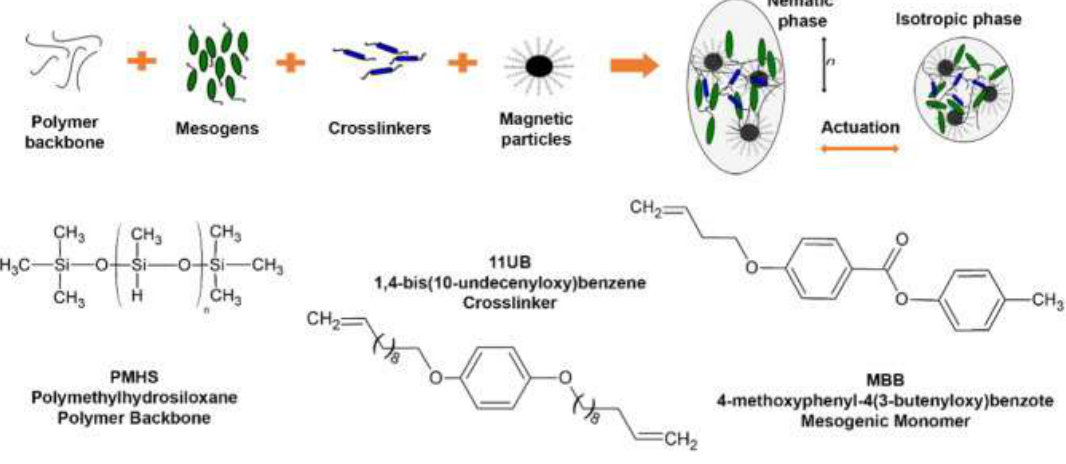
Figure 7. Scheme of the preparation of the composites made from magnetic iron-oxide nanoparticles and a side-chain LCE matrix. Chemical structure of the liquid-crystalline elastomer precursors: the polysiloxane chain (PMHS), the flexible cross-linker (11UB), and the mesogenic monomer (MBB). Reproduced with permission from the authors of [65]. Copyright © 2018 Elsevier.